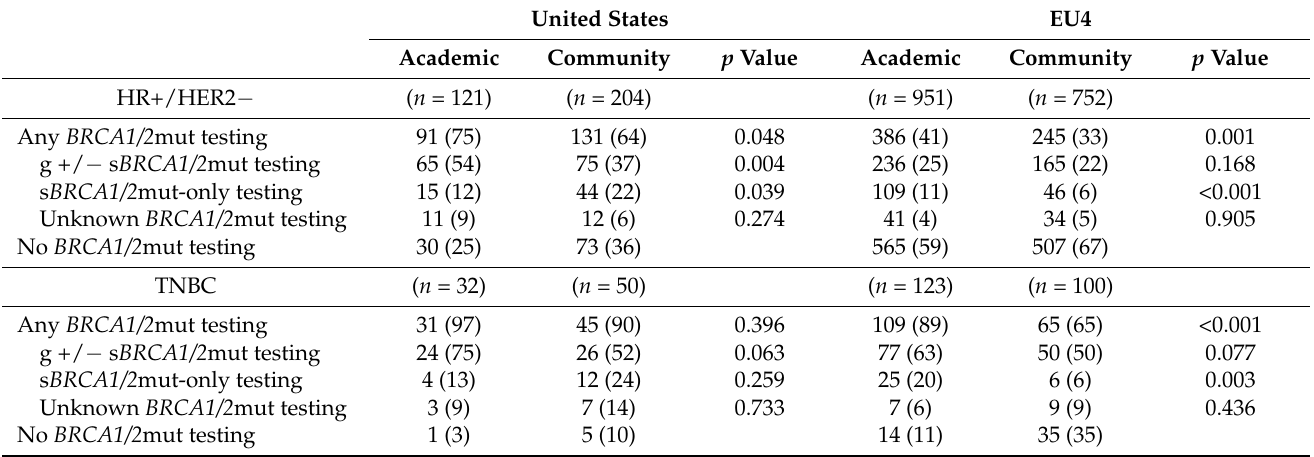
Table 3. BRCA1/2 mut testing rates by practice setting among patients with HER2—ABC in the United States and the EU4.